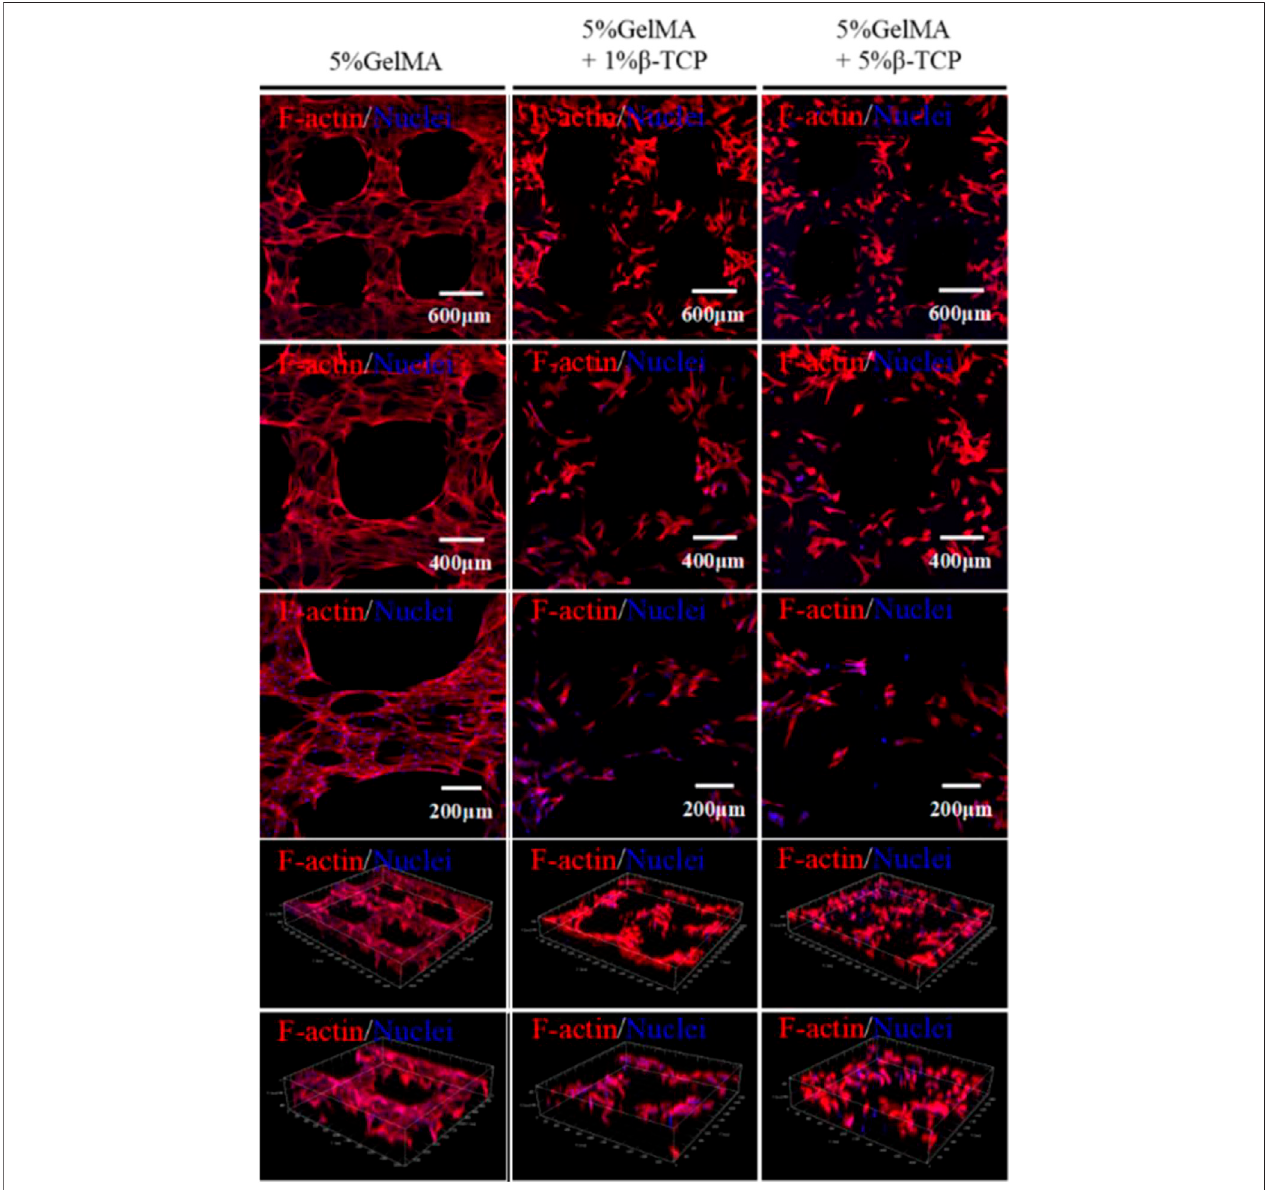
FIGURE5| CytoskeletonstructureofratBMSCsattachedtothesurfaceoftheGelMA/ β -TCPhydrogelscaffolds.Aftercontinuouscultureof10days,theGelMA/ β - TCP hydrogel scaffold loaded with BMSCs was taken out for cytoskeleton staining with Rhodamine labeled Phalloidin, and nuclear staining with DAPI. Images were captured by scanning laser confocal